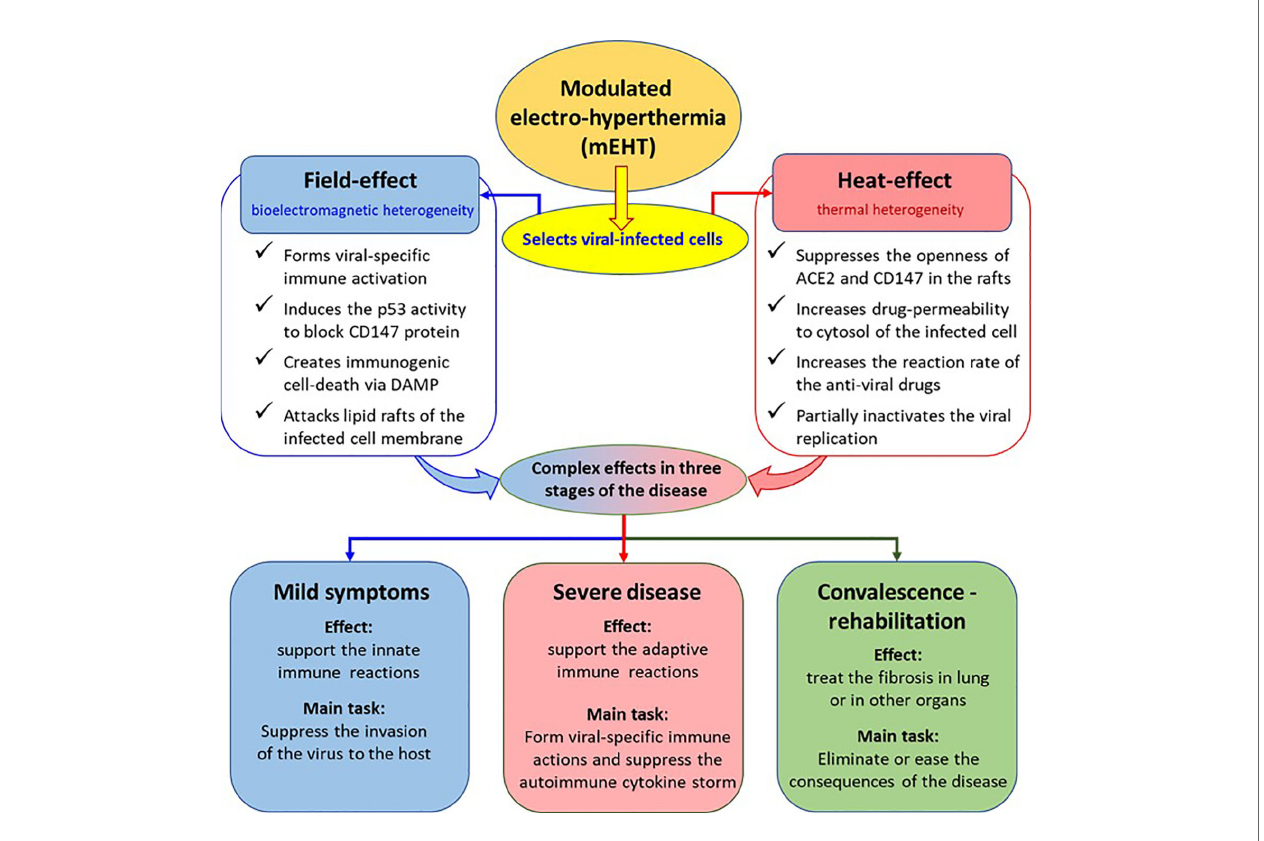
FIGURE 1 | The possible action of mEHT treatment in COVID-19. The effects are deduced from results observed in